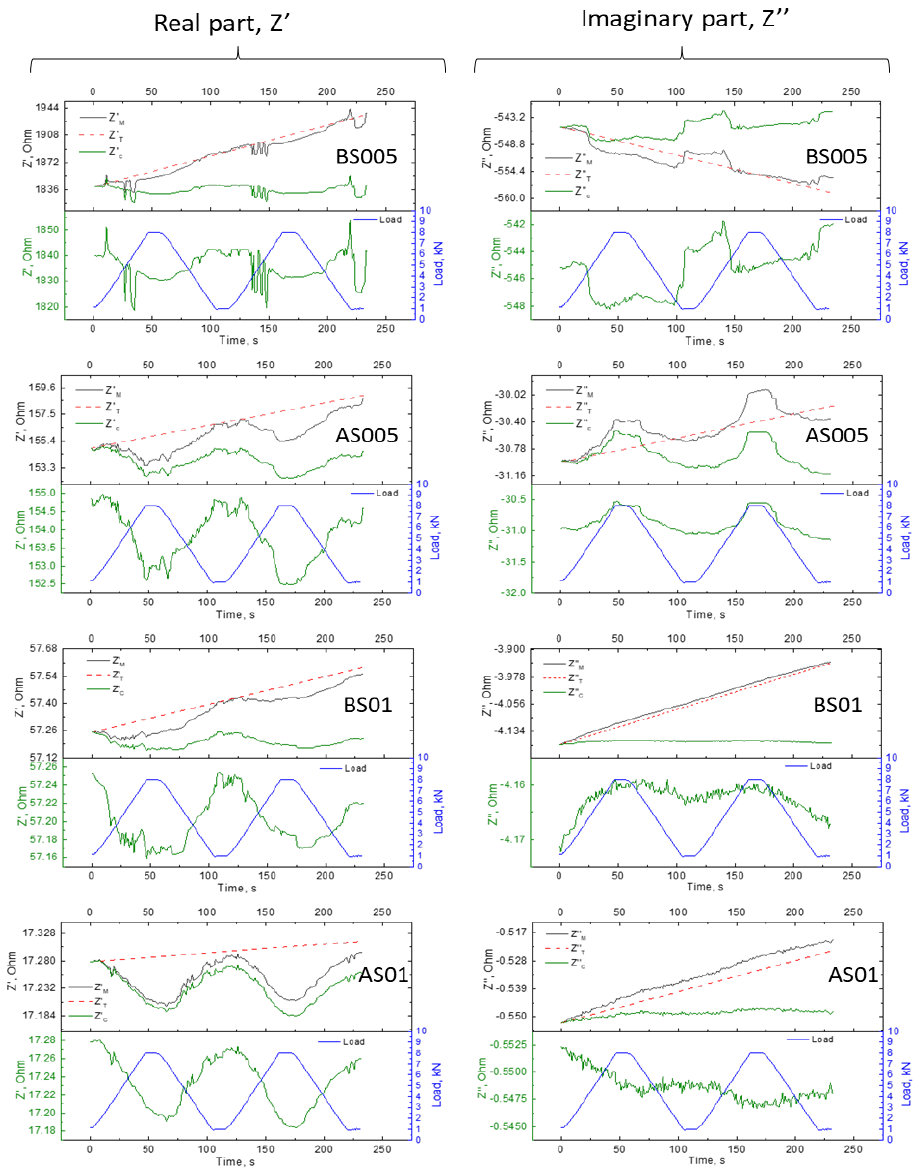
Figure 9. Variations of Z ′ (left) and Z ″ (right) during coupled loading and varying temperature conditions (preheated at 50 °C and cooling during the loading cycling) for representative samples of BS005, AS005, BS01, and AS01 mortars. Temperature-compensated results are also shown and compared with the loading.